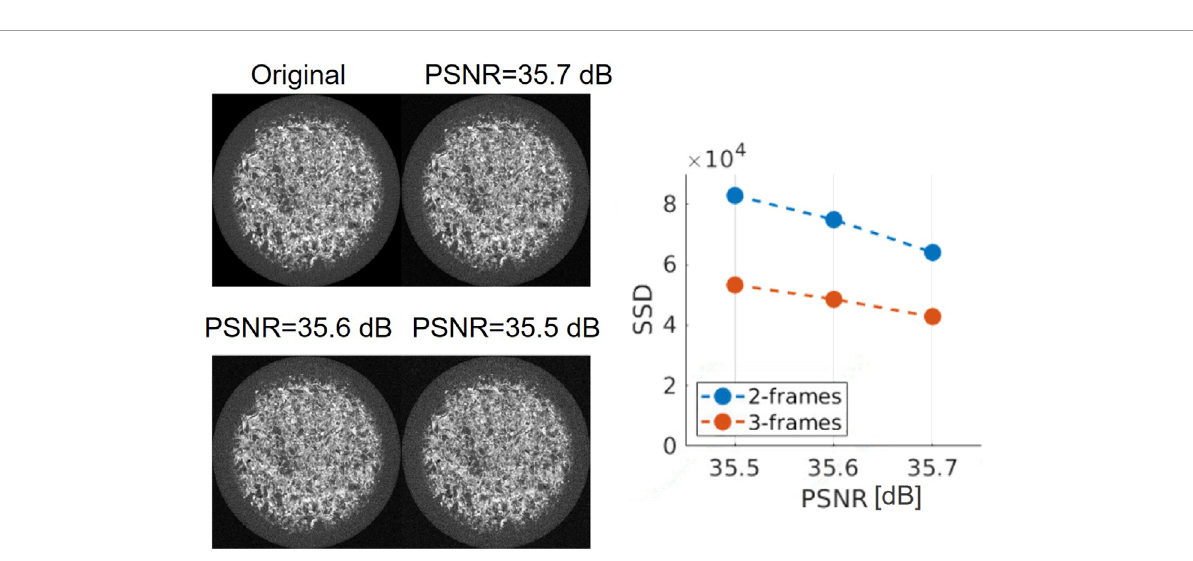
FIGURE 7 Central slice of the tablet acquired after 30 min, without additional noise and with additional simulated noise. PSNR ranges from 35.5 to 35.7 dB. In the graph on the right of the Figure, the SSD variation as noise changes is reported for 2-frames-conc and 3-frames